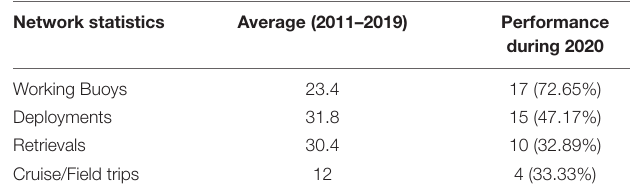
TABLE 1 | The performance of the moored buoy network during the year 2020 amid COVID-19 pandemic. Network